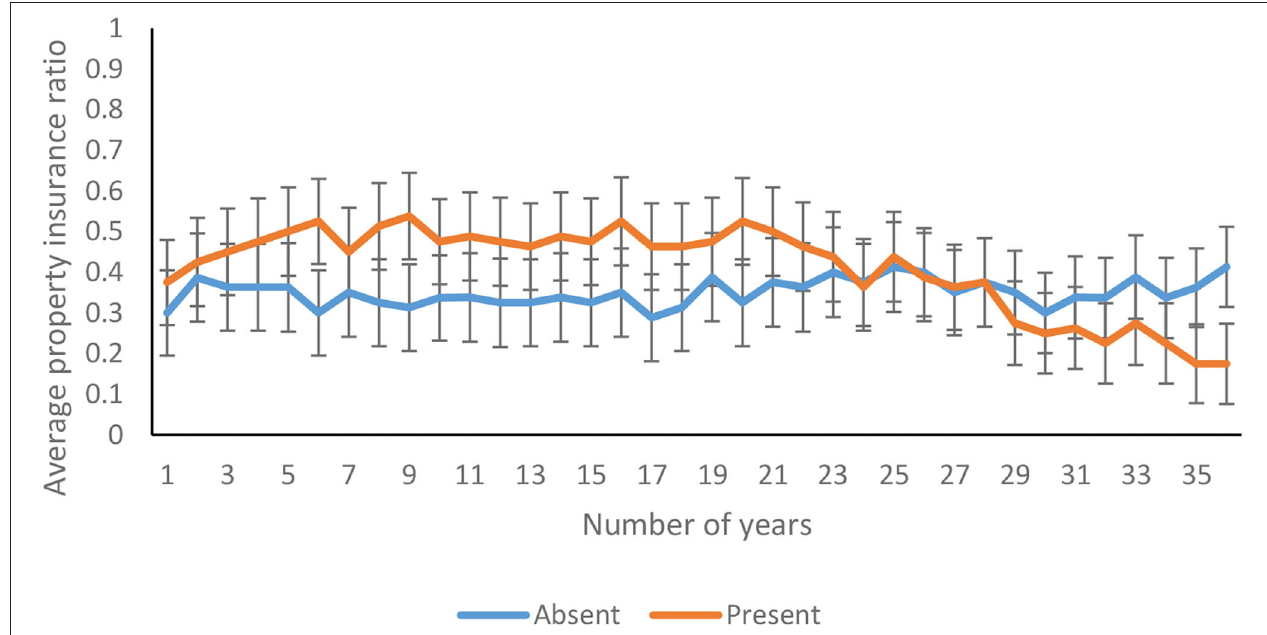
FIGURE 11 | Average property insurance ratio over years in feedback-present and absent conditions. The error bars show 95% CI around the point